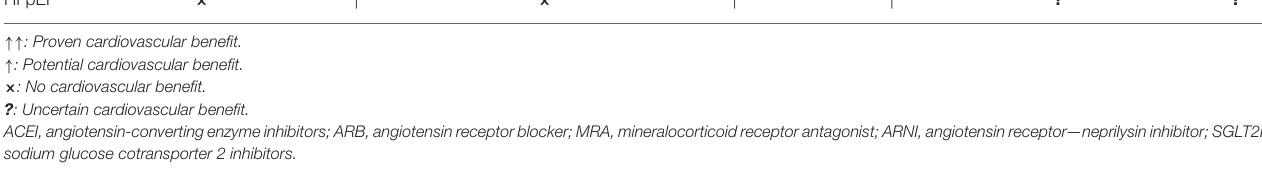
TABLE 2 | Medical therapy in heart failure. ACEI ARB Beta-blocker MRA ARNI SGLT2I Diuretic HFrEF